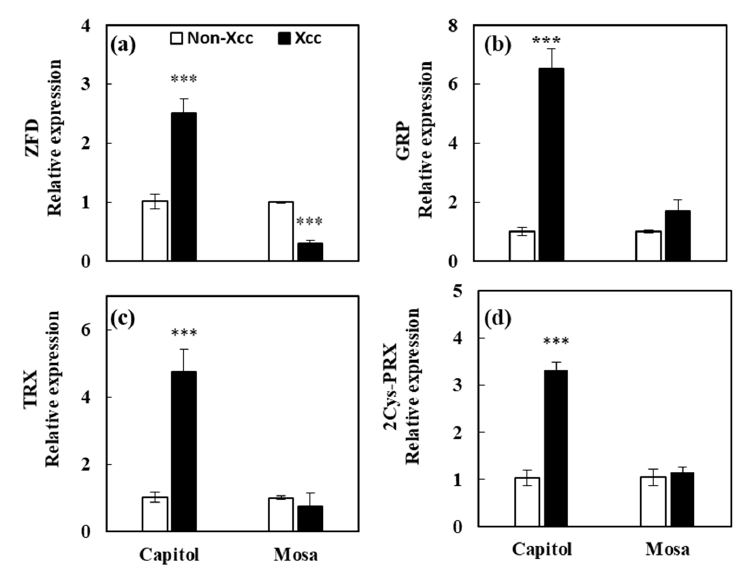
Figure 8. Relative expression of genes ( a ) zinc finger SWIM domain-containing 7 isoform X2 (ZFD), ( b ) glycine-rich RNA-binding GRP1A isoform X1 (GRP), ( c ) thioredoxin (TRX), ( d ) 2-cys peroxiredoxin (2Cys-PRX) in control (open bar) and Xanthomonas campestris pv. campestris (Xcc)-inoculated (filled bar) leaves of two different B. napus cultivars as affected by Xcc inoculation. Asterisks indicate significant differences between the Xcc noninoculated (control) and Xcc-inoculated plants; *** p < 0.001.